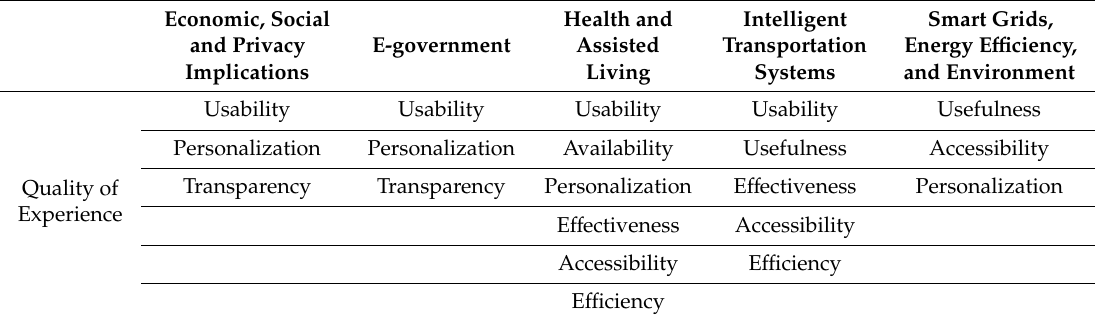
Table 1. Impact of quality of experience on sensor city, derived from